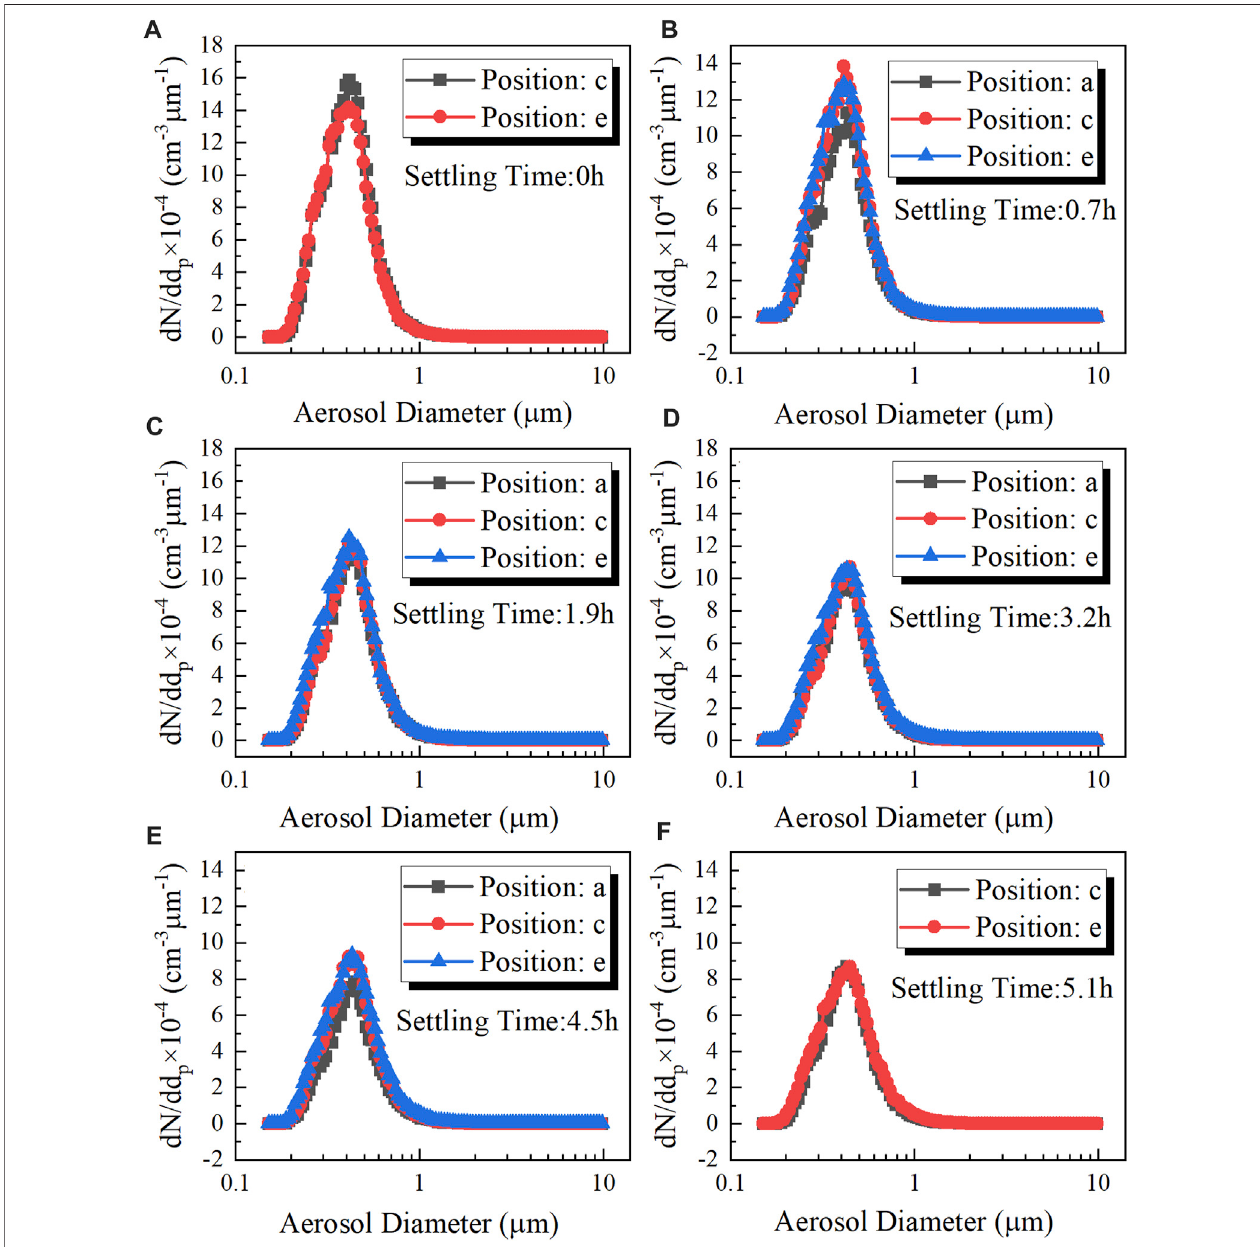
FIGURE 9 | Evolution of the size distribution of the aerosol at different elevations: (A) 0 h, (B) 0.7 h, (C) 1.9 h, (D) 3.2 h, (E) 4.5 h, and (F) 5.1 h.